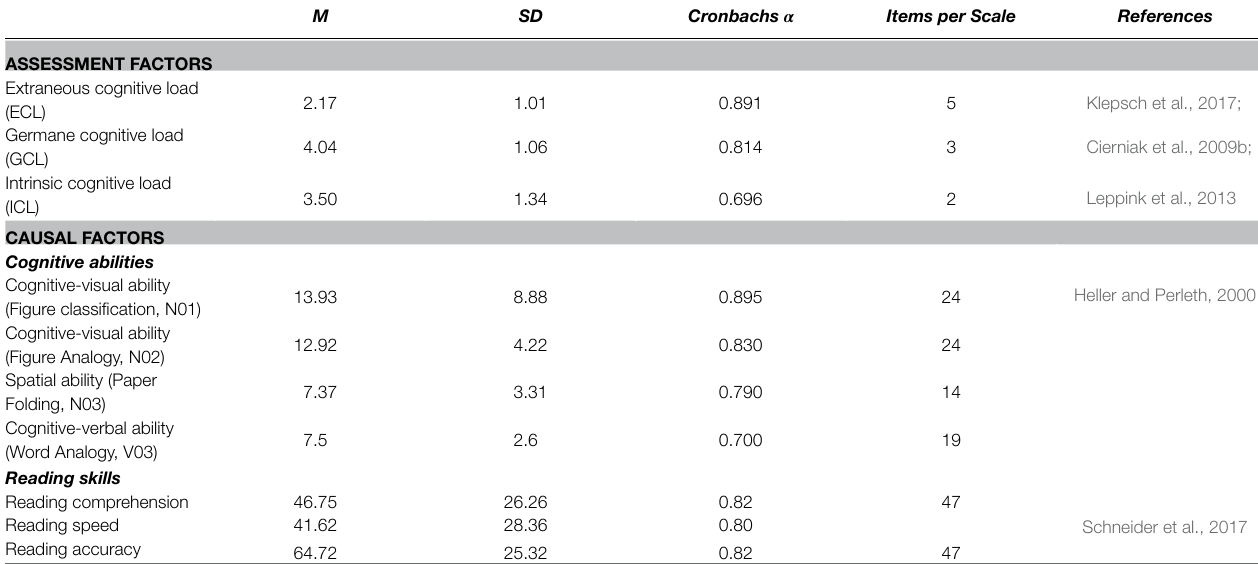
TABLE 2 | Descriptive data of used measurement of assessment and causal factors for the total sample.